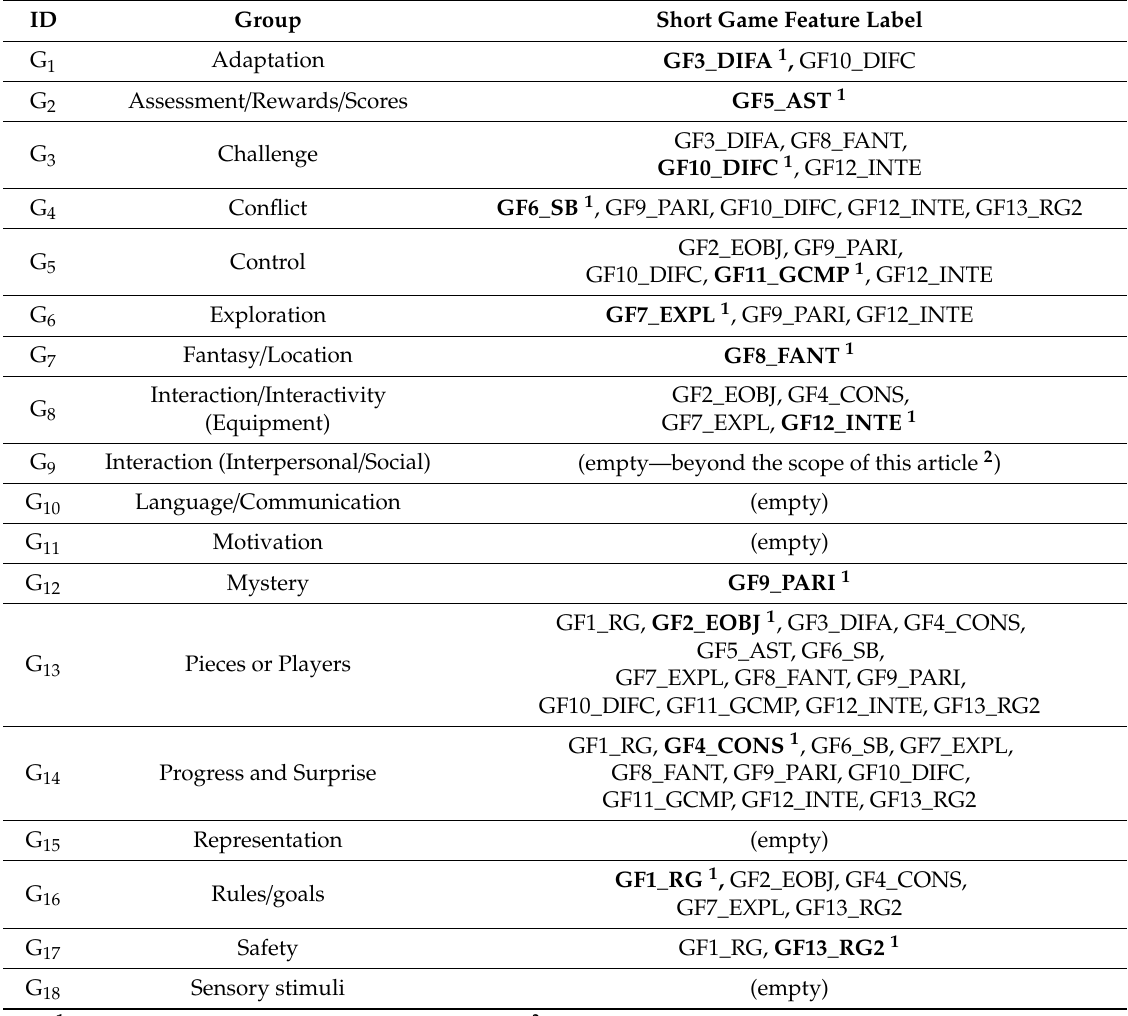
Table 2. Game definition groups and their game feature